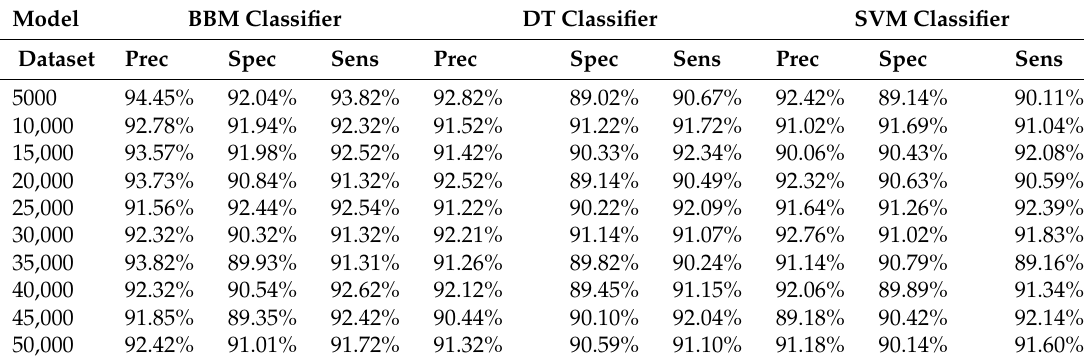
Table 3. Categorization Efficacy; (Prec Precision, Spec Specificity, Sens